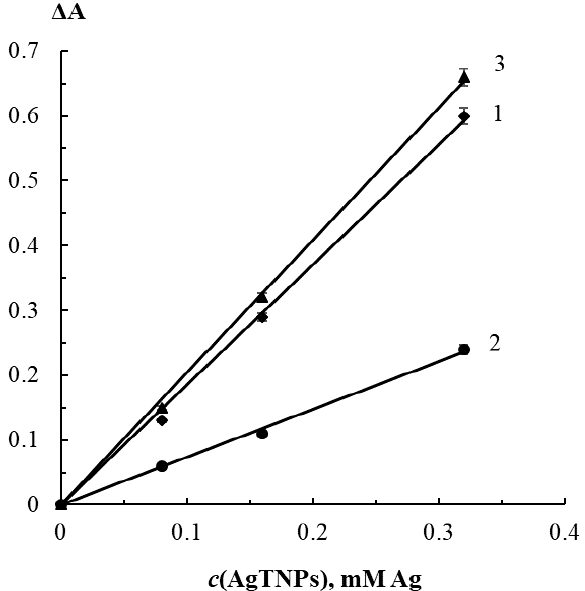
Figure 6. Change in the absorbance of AgTNPs solutions in the presence of 50 µ M hydrogen peroxide (1), 300 µ M tert -butyl hydroperoxide (2) and 3 µ M peracetic acid (3) depending on the AgTNPs concentration. pH 6, t = 20 min.